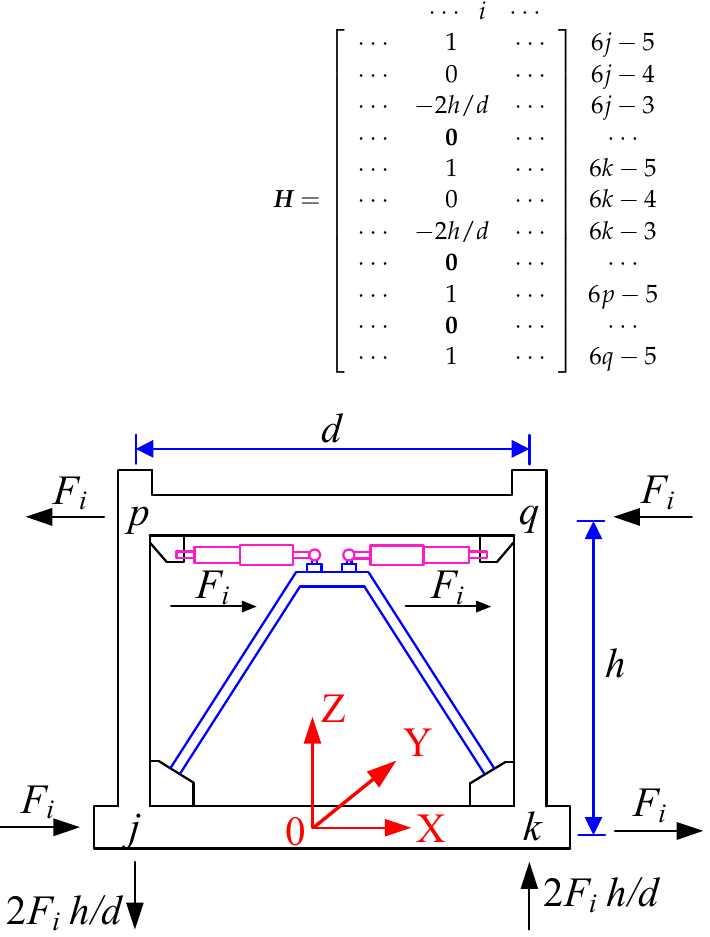
Figure 5. The schematic diagram of damping force distribution.